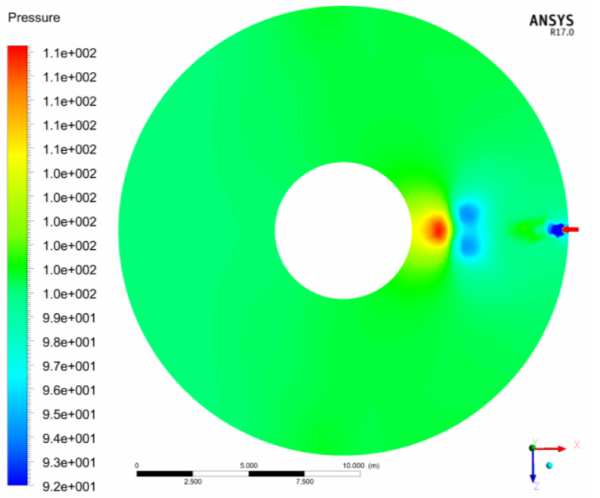
Figure 6. Static pressure on the xz plane at 5 × 10 − 2